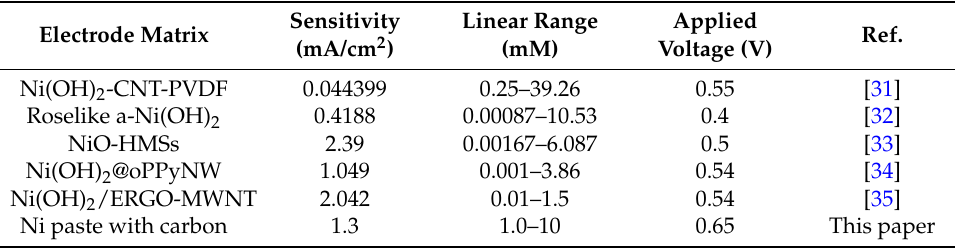
Table 3. Comparisons of glucose performances of the Ni(OH) 2 /NiOOH-DSPNCE with the recently reported nickel-based non-enzymatic glucose sensor.